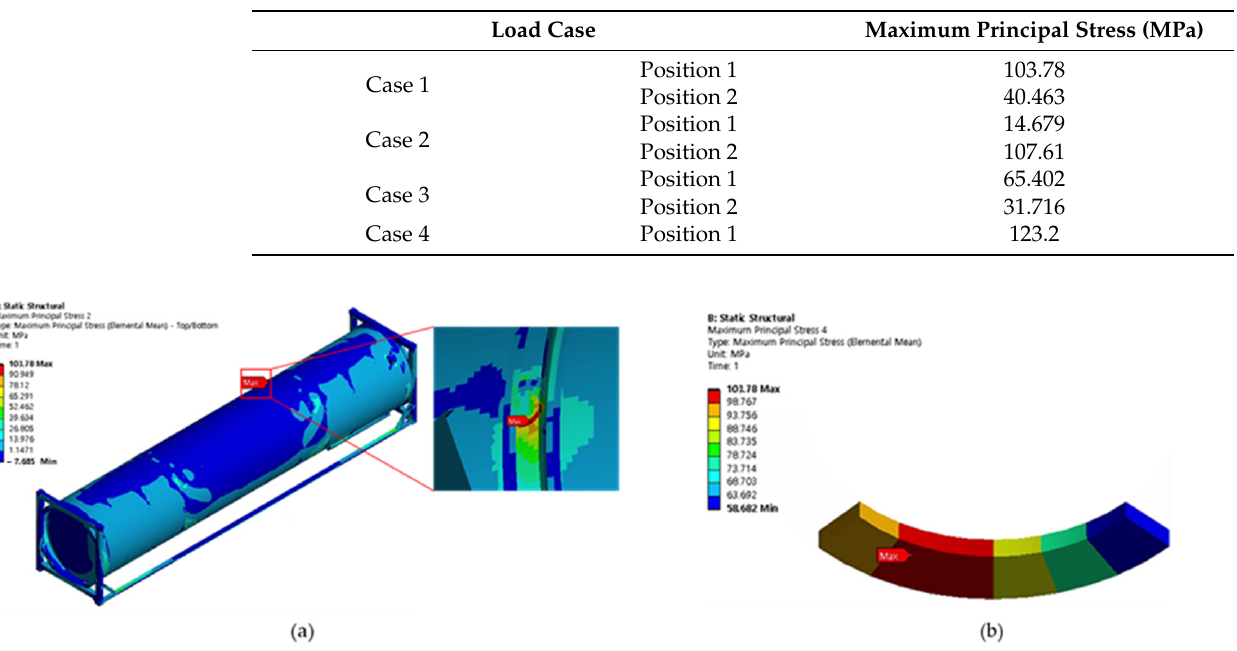
Figure 5. Case 1 principal stress distribution. ( a ) Entire computational domain showing region of maximum stress (position 1). ( b ) Position 1 element analysis result in detail.